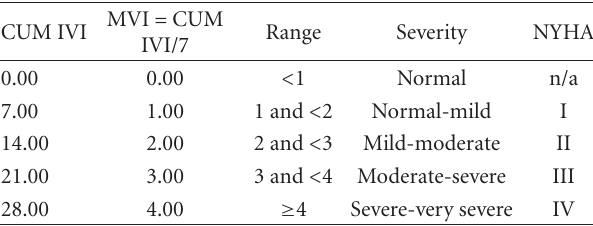
Table 4: MVI scoring system weighted for the slope of change and magnitude of change in PetCO 2 (indicative of exercise induced PH). MVI PH Modifier ≥ 0 0.00 < 0 and > − 5 0.50 ≥− 5 and > − 10 0.75 ≤− 10